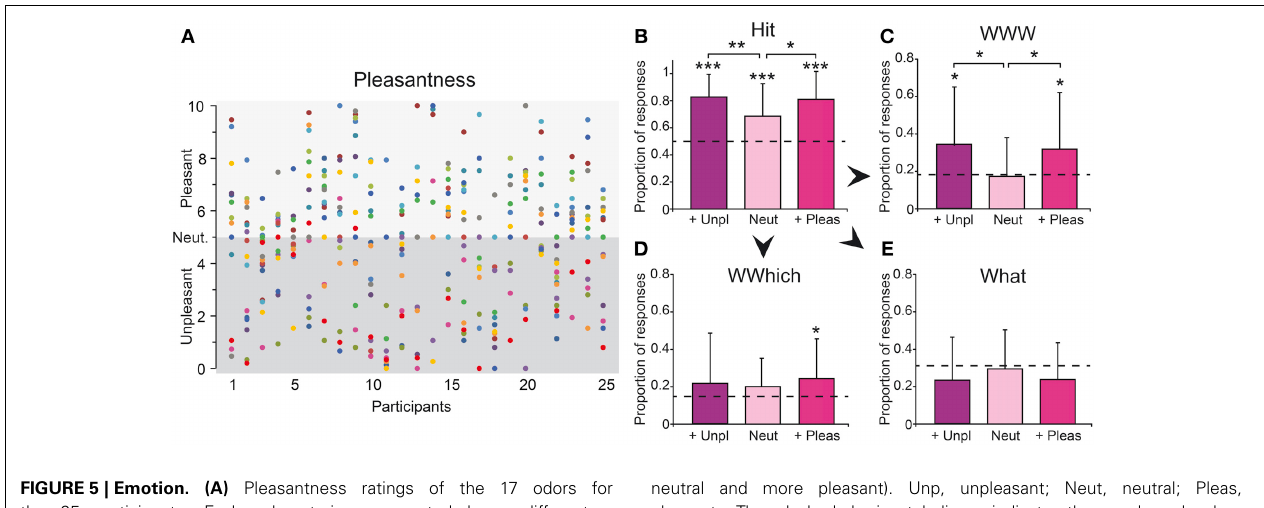
neutral and more pleasant). Unp, unpleasant; Neut, neutral; Pleas, pleasant. The dashed horizontal lines indicate the random levels computed for each response. Vertical bars represent the SD; ∗ p < 0 . 05; ∗∗ p < 0 . 01.